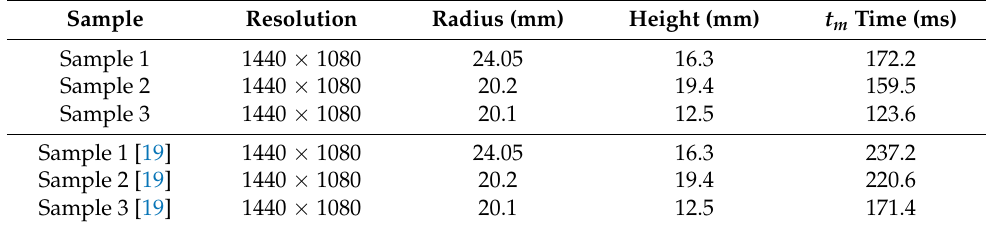
Table 2. The average unfolding and stitching time t m for 1.6-megapixel color cap